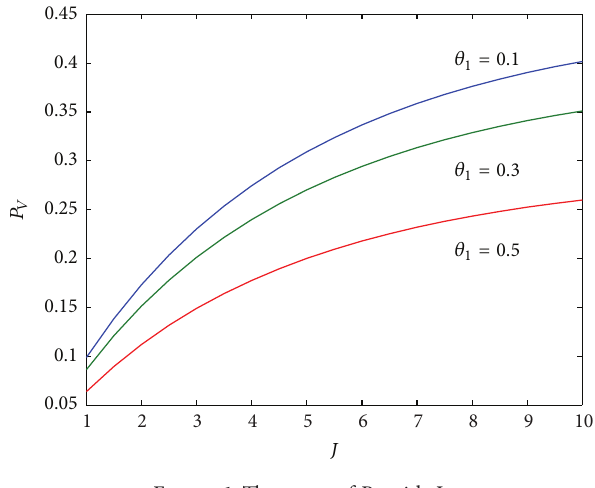
Figure 1: The curve of 𝑃 𝑉 with 𝐽